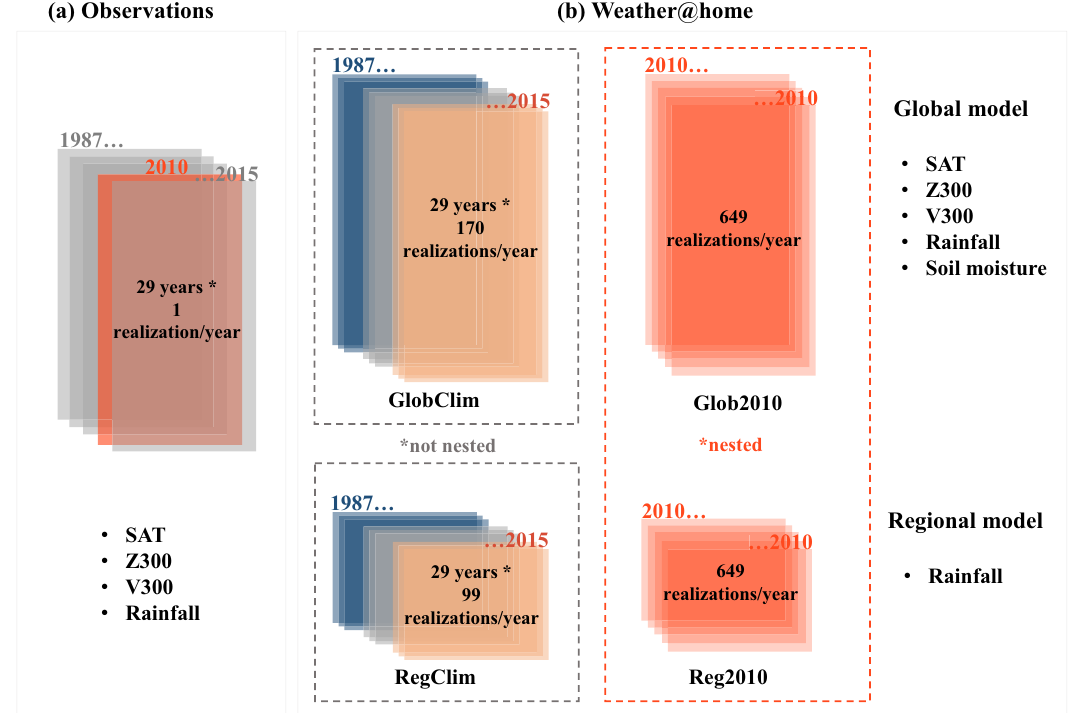
Fig. 2 Schematic of model experiment. Panel a : Observations. Panel b : weather@home climatology for the global model (GlobClim) and for the regional model (RegClim) (gray dashed box) and 2010 large-ensemble for the global model (Glob2010) and for the regional model (Reg2010) (red dashed box). While Reg2010 is directly nested on Glob2020, RegClim is nested on a different set of global simulations than those contained in GlobClim. See Supplementary Discussion 1 for further